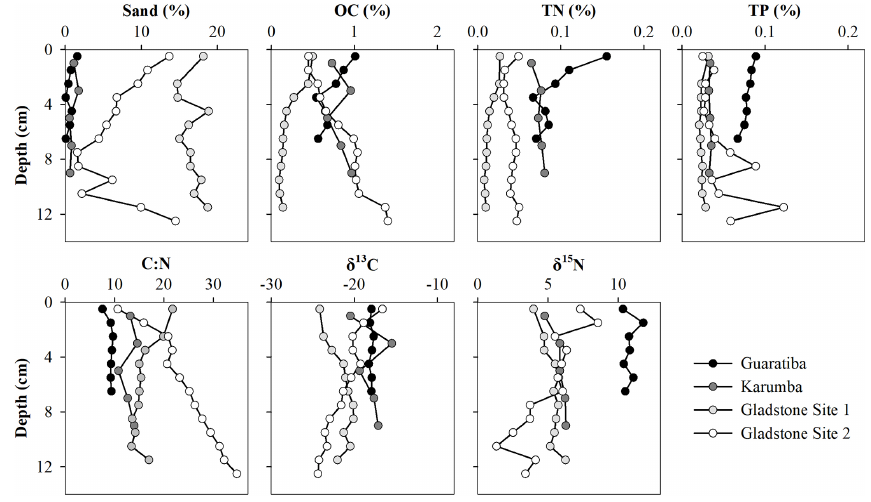
Figure 3. Vertical distribution of sand ( > 63µm), organic carbon (OC), total nitrogen (TN) and total phosphorous (TP) contents (%) as well as δ 13 C, δ 15 N and molar C : N ratios of the four hypersaline tidal flat sediment